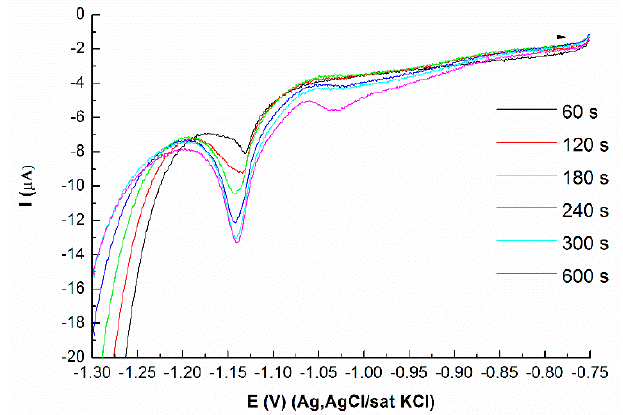
Figure 5. Cathodic stripping curves of Se deposited at E = − 0.85 V on Mo ad /Ag(111) in NaOH 0.1M. The scan rate is 10 mV·s − 1 . The curves refer to deposition times from 1 to 10 min.